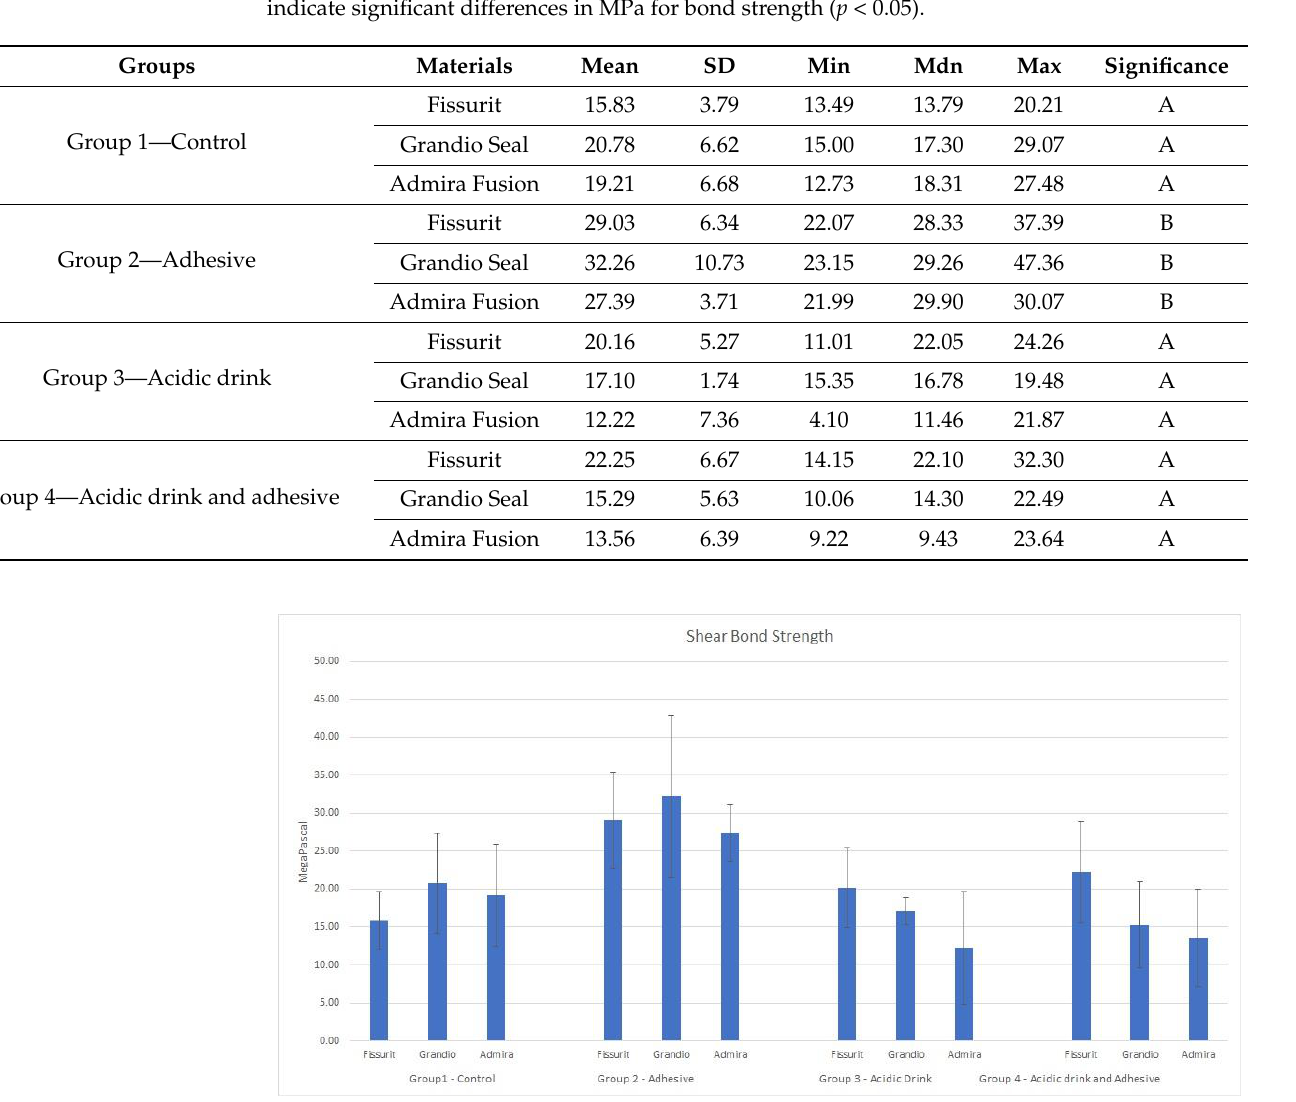
Figure 2. Mean and SD of the different groups tested.